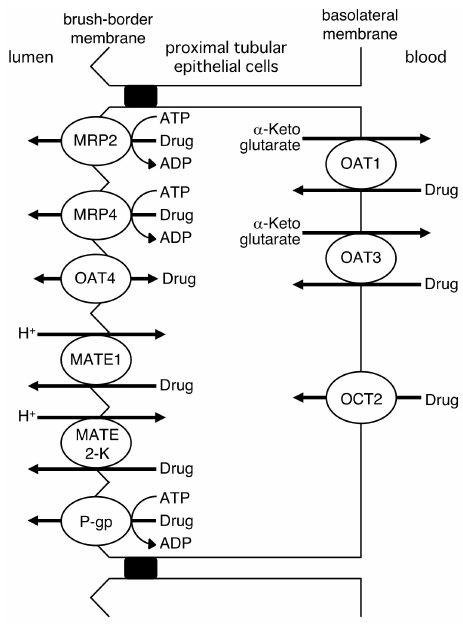
Figure 4. Drug transporters mediating renal tubular secretion drugs.